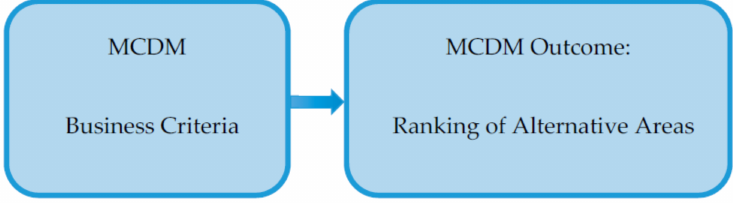
Figure 3. Current MCDM